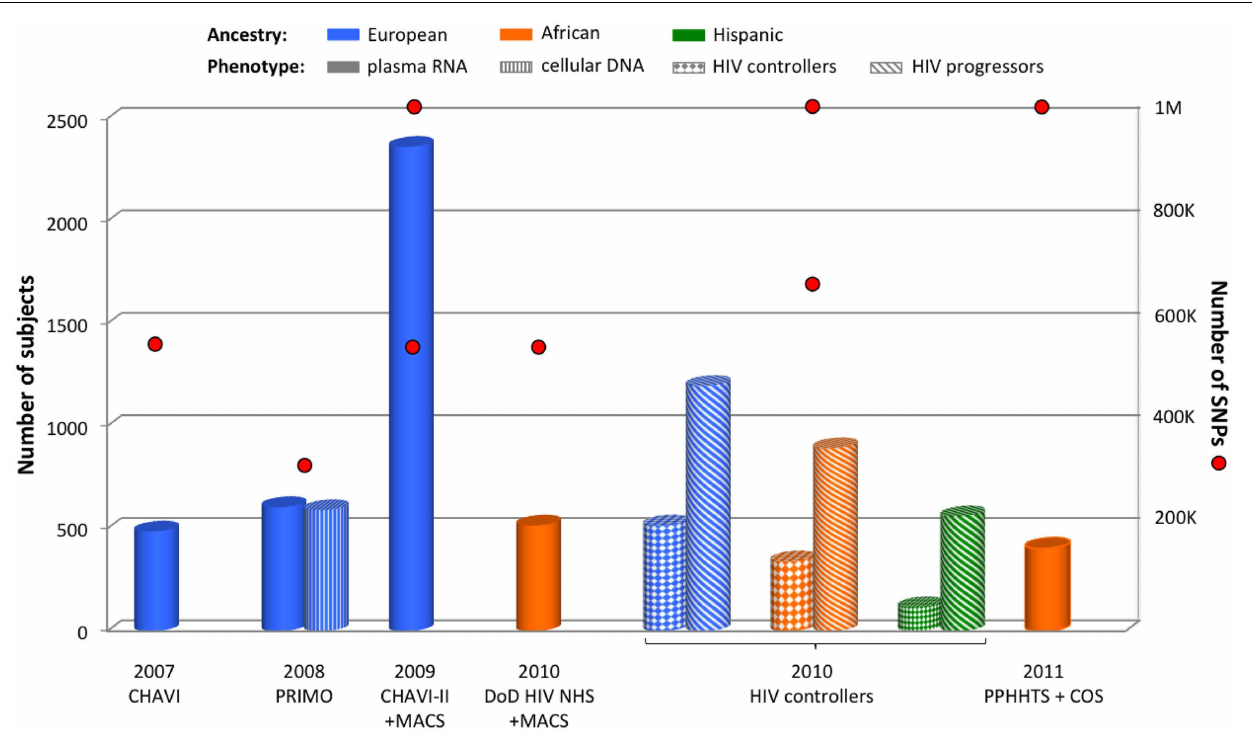
FIGURE 1 | Summary of GWAS design focusing on viral load control .The histogram presents the number of subjects and red circles display the number of SNPs covered by the genotyping arrays.Two red circles are symbolized for one cohort when individuals were genotyped using two sets of arrays.